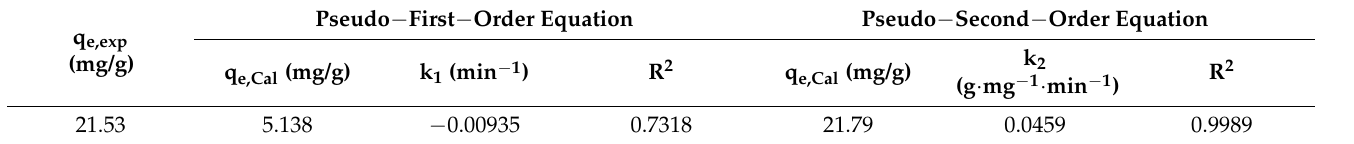
Figure 8. ( a ) Adsorption isotherm, ( b ) pseudo − first − order model, and ( c ) pseudo − second − order model of HNM-4. Table 2. Adsorption kinetic model parameters and correlation coefficients (R 2 ) for SO 42 − adsorption by HNM ‐ 4.